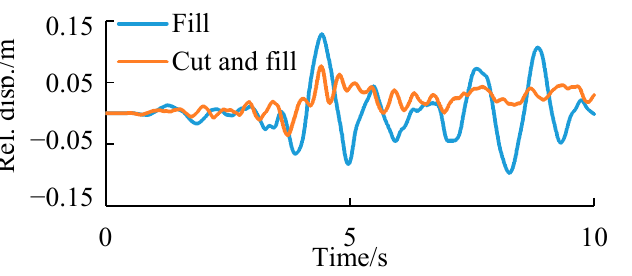
Figure 18. Displacement time-history curves of the relative displacement of top and toe for the two types of subgrades.